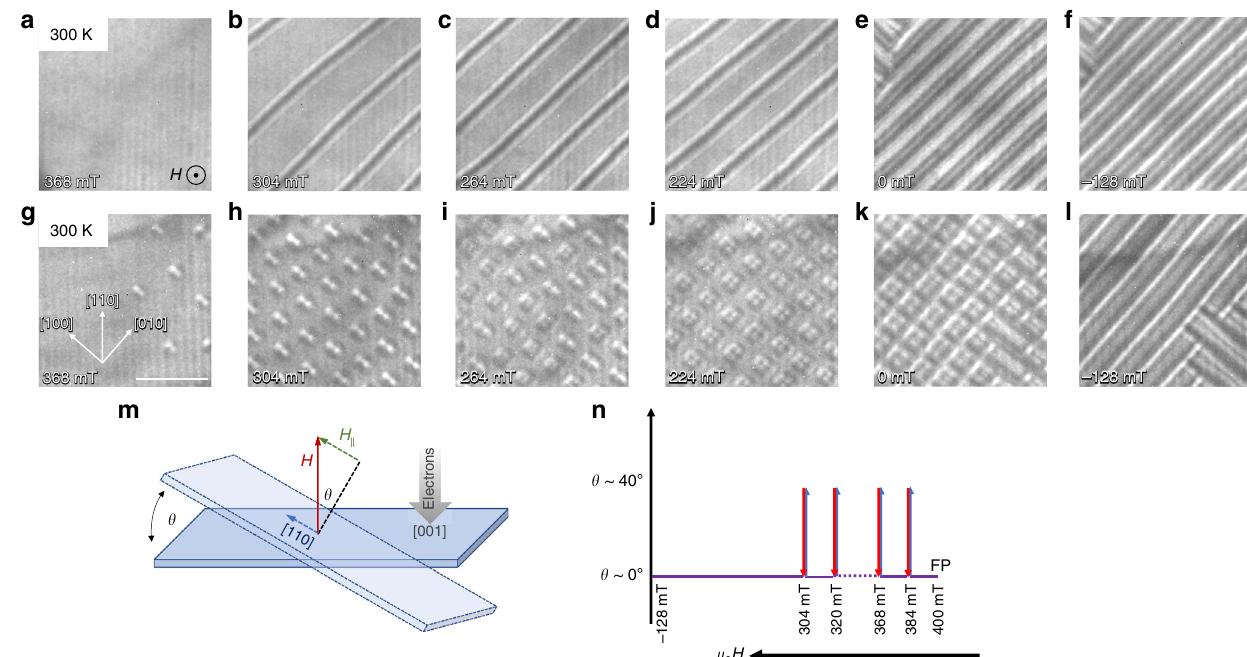
Fig. 1 Field-induced stabilization of antiskyrmions in D 2d material. The top row ( a – f ) shows the observation under the decreasing fi eld mode at 300 K. A magnetic fi eld is applied and decreased coming from the fi eld-polarized phase. The texture exhibits helices with decreasing period length. In the bottom row ( g – l ) we apply the modi fi ed protocol (see schematic fi gures m , n ) where we tilt the fi eld B by 35° – 40° in the [1 1 0] direction and come back to [0 0 1] orientation (as indicated) at high fi elds until a dense array of antiskyrmions has formed in h . We observe two different types of features: round ones indicating conventional antiskyrmions and square ones, which are topologically identical to antiskyrmions. A highly periodic lattice of the square objects is metastable even at vanishing fi eld ( k ) and transforms into the helical phase only at a negative fi eld of − 128 mT. The scale bar corresponds to 500 nm. In m we show the tilting of the sample and n illustrates the procedure that was used for the measurement of the LTEM images shown in g – l .